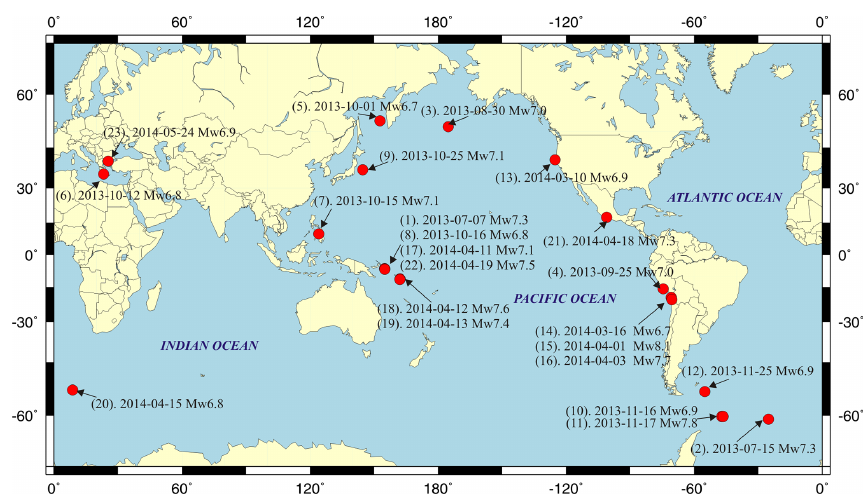
Figure 1. Locations of the epicenters (red dots), event number (given in Table 1), date of occurrence and magnitudes of submarine earthquake events of M w > = 6.7 that were analyzed during a 1-year period from June 2013 to June